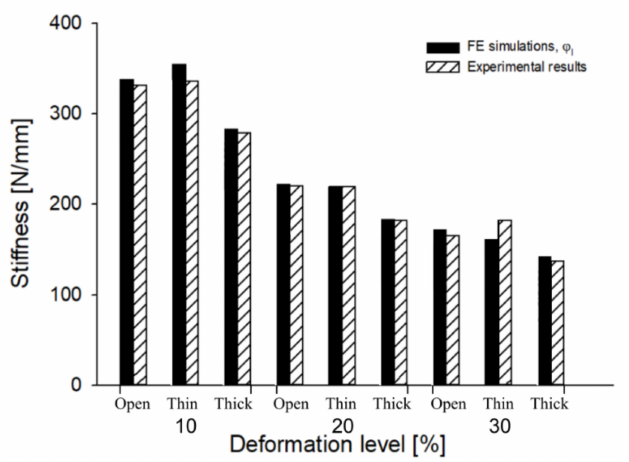
Figure 15. Experimental results and FE simulations corrected with ϕ l